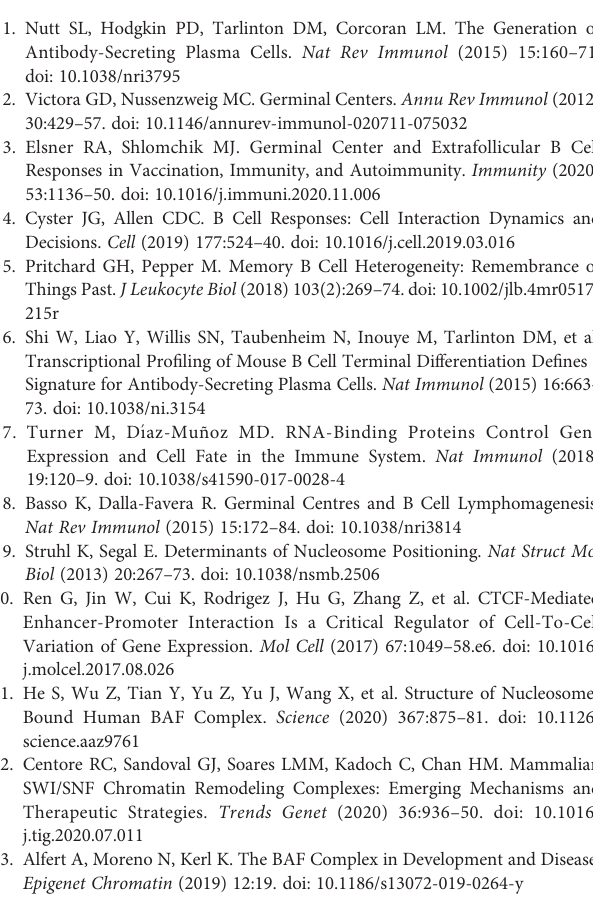
752 ATAC-seq peaks with signi fi cantly reduced chromatin accessibility in Brg1- de fi cient cells, and 322 ATAC-seq peaks with signi fi cantly increased chromatin accessibility in Brg1-de fi cient cells. (J) Venn diagram showing overlap between 13,890 Brg1 bound ATAC-seq peaks, 752 ATAC-seq peaks with signi fi cantly reduced chromatin accessibility in Brg1-de fi cient cells, and 322 ATAC-seq peaks with signi fi cantly increased chromatin accessibility in Brg1-de fi cient cells. Supplementary Figure 2 | Brg1 is not critical for the expression of Blimp-1 and IRF4 in B cells following LPS activation. (A) Gating strategy used for analysis of PCs in BM samples. (B) Analysis of IRF4 and Blimp-1 protein levels assessed by intracellular fl ow cytometry in CD23-Cre littermates or Brg1 fl / fl splenic B cells before and after 4 days activation with LPS and IL-4. Statistics were calculated with students ’ t-test. (C) Gating strategy applied to detect GC B cells in lymph nodes and PPs. Supplementary Figure 3 | Brg1 is required for the generation of IgG1+ germinal centers B cells in Peyer ’ s patches. (A) Analysis of germinal center size in PPs of g 1- Cre control (littermate or Brg1 fl /+ ) or Brg1 fl / fl mice analyzed by fl ow cytometry. Statistic s were calculated with students ’ t-test. (B) Analysis of class-switch recombination to IgA and IgG1 in Peyer ’ s patches of g 1-Cre control (littermate or Brg1 fl /+ ) or Brg1 fl / fl mice analyzed by fl ow cytometry. Statistics were calculated with students ’ t-test. (C) Analysisofclass-switchrecombinationtoIgG1insplenicBcells derived from littermate, Brg1 fl /+ or Brg1 fl / fl CD23-Cre mice after 4 days activation with LPS and IL-4. Statistics were calculated using one-way ANOVA with post hoc Tukey ’ s multiple comparisons. CellTrace Violet staining indicates the magnitude of B cell